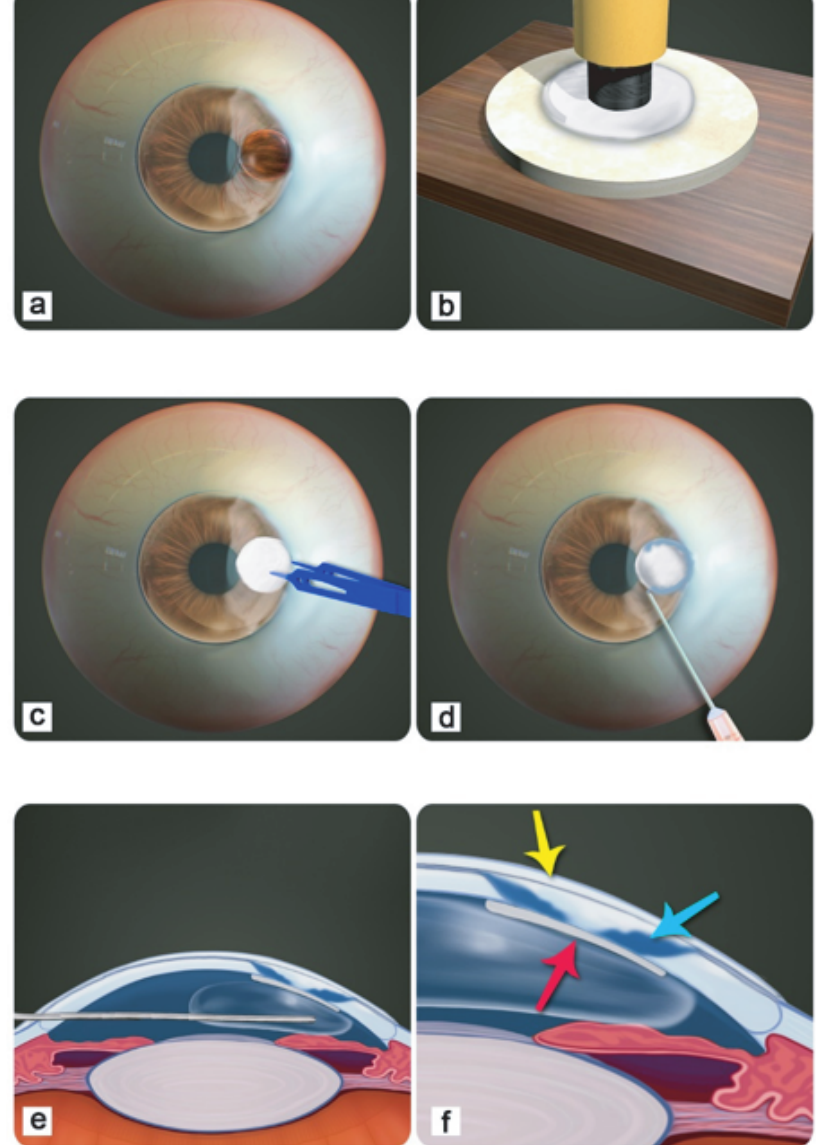
Figure 2. Diagramatic presentation of retrocorneal sclera patch supported cyanoacrylate tissue adhesive application: (a) Corneal perforation (3.5 × 3.5 mm), corneal, limbal and sclera melt; (b) Punching of sclera patch (4.5 × 4.5 mm) using a skin bopsy punch; (c) Placing the thinned sclera patch behind the corneal perforation; (d) Application of minimum quantity of cyanoacrylate tissue adhesive at the margin of perforation on the sclera patch; (e) Injecting an air bubble in the anterior chamber; (f) At completion of surgical procedure, retrocorneal sclera patch (red arrow), cyanoacrlate tissue adhesive (blue arrow), and bandage contact lens (yellow